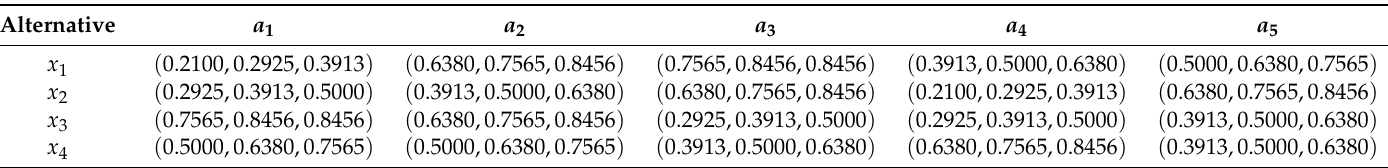
(cid:16) (cid:17) . (cid:101) d ij 2 4 × 5